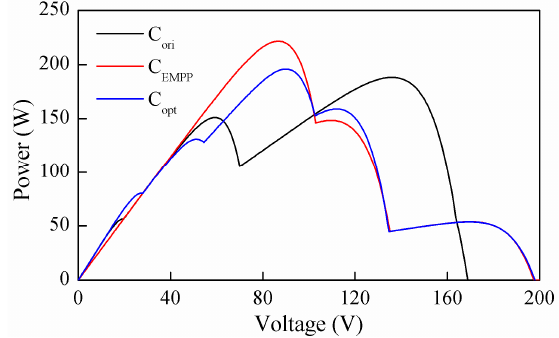
Figure 12. P-V curve of a PV array before and after Figure 12 . P-V curve of a PV array before and after reconfiguration.